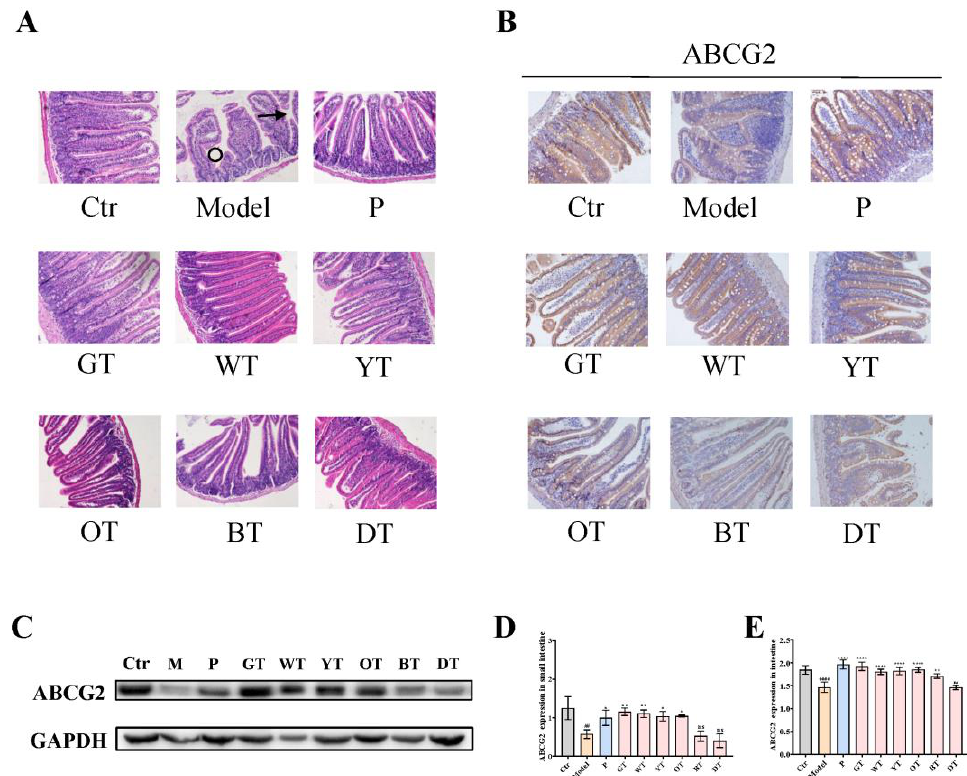
Figure 6. Mechanism of TWEs on UA metabolism in the small intestine. ( A ) Representative H&E- stained small intestine tissue images of different treatment groups: arrows indicate villous shedding and circles indicate abnormal crypt structure (200 × ). Representative immunoblots ( B ) and IHC ( C ) images of ABCG2 expression in the small intestine. Quantification of ABCG2 expression by Western blotting ( D ) and IHC ( E ). The data are expressed as mean ± SD. ## p < 0.01, #### p < 0.0001 were compared with the control, ns p > 0.1, * p < 0.1, *** p < 0.001, **** p < 0.0001 were compared with the model.